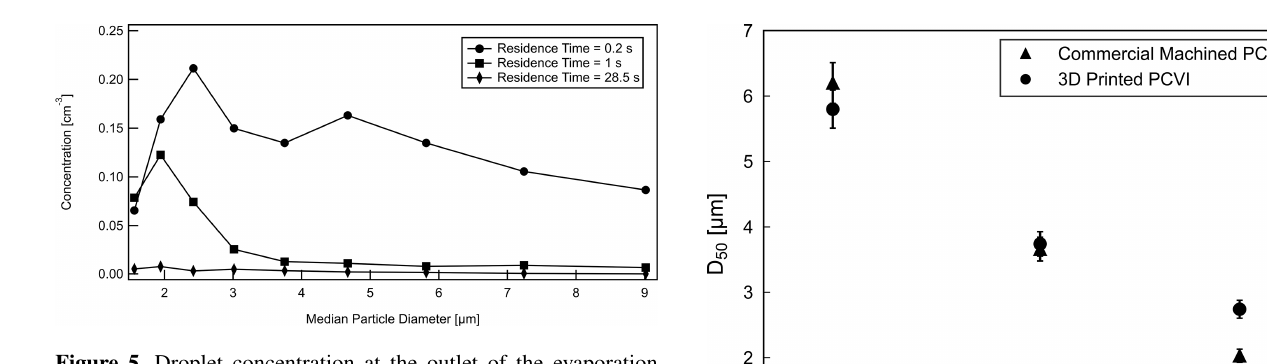
Figure 5. Droplet concentration at the outlet of the evaporation chamber as a function of the optical particle diameter for different residence times.